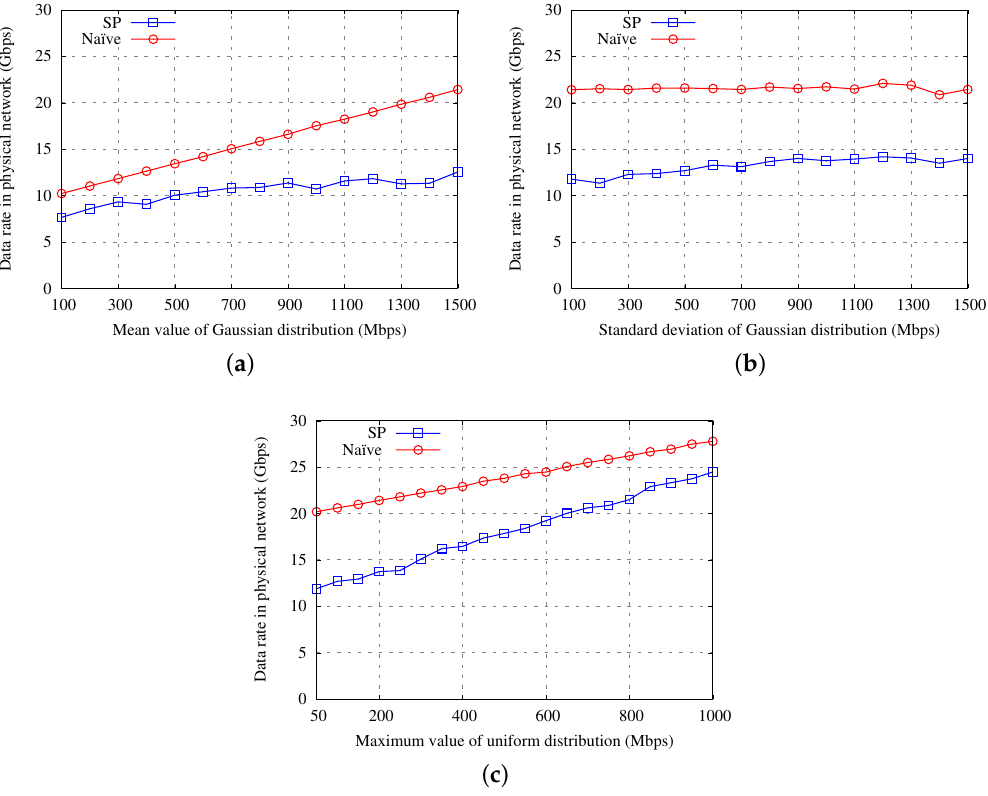
Figure 7. Aggregate data rate in physical network for different traffic patterns between VMs: ( a ) mean values for the Gaussian distribution; ( b ) standard deviations for the Gaussian distribution; and ( c ) maximum values for the uniform